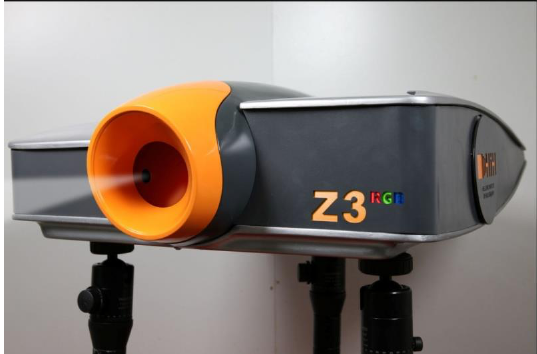
Figure 1. The ZZZyclops color holography camera (the white beam is emulated) (© 2013 HiH).